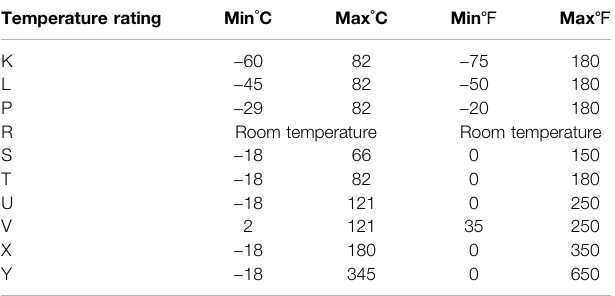
TABLE 2 | API temperature rating